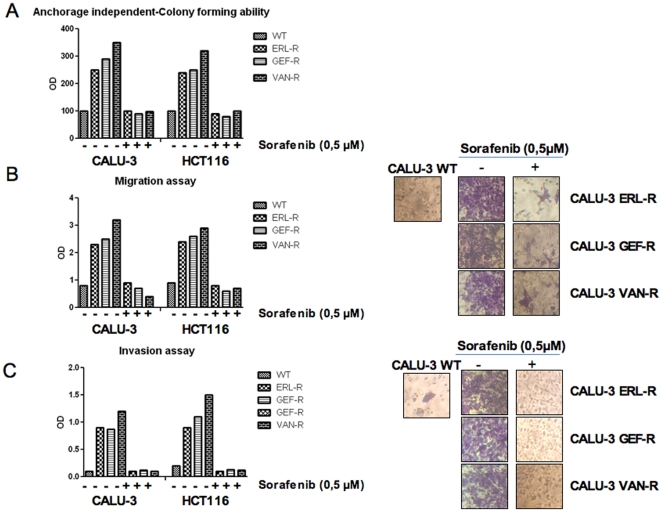
Effects of treatment with sorafenib on the invasive, migratory and anchorage-independent colony forming capabilities of TKI-resistant CALU-3 and HCT116 cancer cells.Anchorage-independent growth (A), migration (B) and invasion (C), were evaluated in TKI-resistant CALU-3 and HCT116 derivatives (ERL-R, GEF-R, VAN-R) after treatment with the indicated concentrations of sorafenib. The results are the average ± SD of three independent experiments, each done in triplicate. Representative pictures are shown for the migration and invasion abilities of CALU-3 WT and Resistant cell lines.